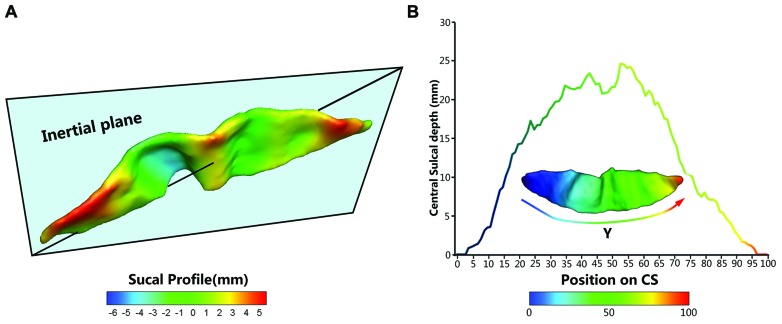
The central sulcal profile and the Depth-Position Profile (DPP). (A) Central sulcal profile coded by different colors (from negative in blue to positive in red) which is defined the signed distance between each vertex on the CS surface and inertia plane. (B) A CS mesh with y coordinate field and its depth curve which is defined as the distance between the paired points at the sulcal fundus and the brain envelope that shared the same y coordinate along the parameterized sulcal mesh surface.